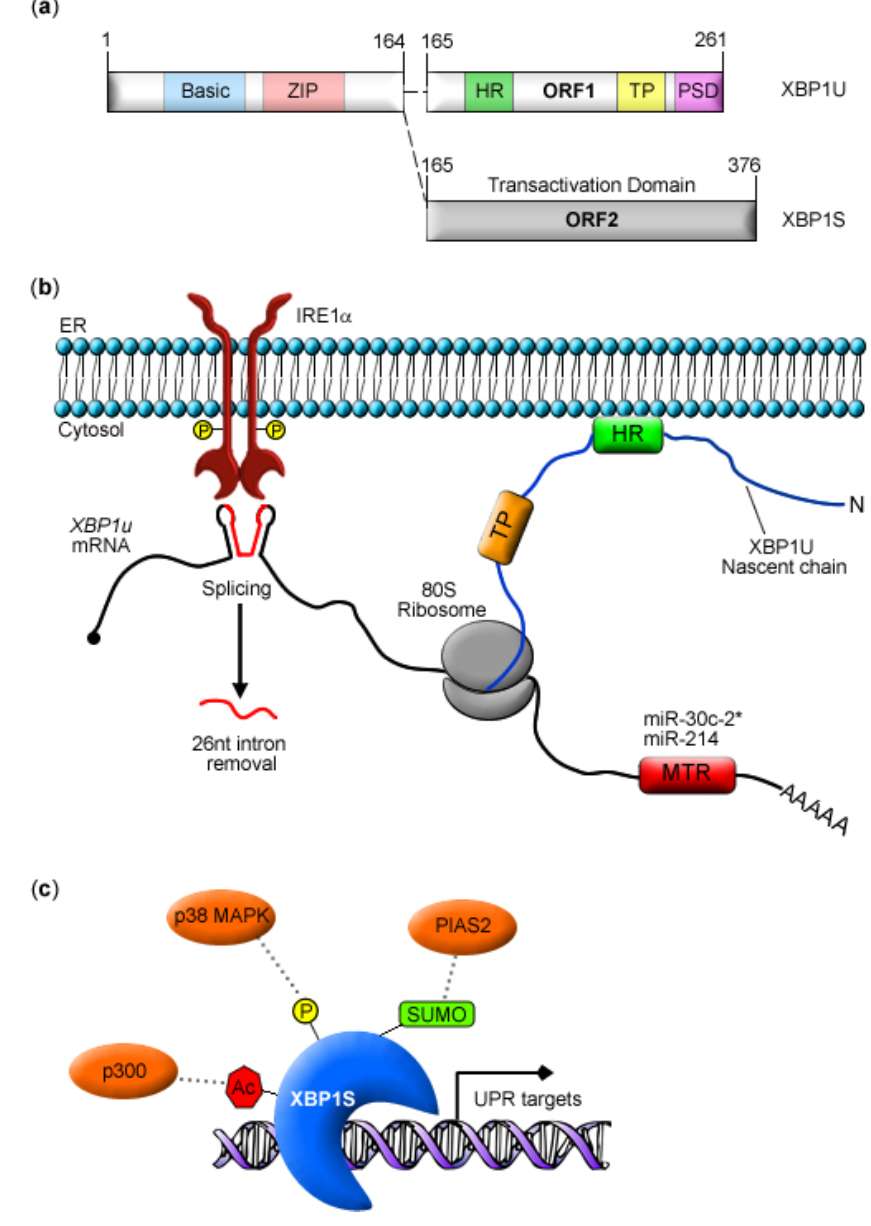
Figure 1. Regulatory elements of XBP1 expression and activity. (a) Figure of XBP1 protein variants (XBP1U and XBP1S). Numbers indicate amino acid positions. Basic and leucine zipper (ZIP) domains are indicated as well as ORF1 and ORF2 in the carboxyl-terminal domain of XBP1U and XBP1S, respectively. Hydrophobic region (HR), (cid:87)(cid:85)(cid:68)(cid:81)(cid:86)(cid:79)(cid:68)(cid:87)(cid:76)(cid:82)(cid:81)(cid:68)(cid:79)(cid:3) (cid:83)(cid:68)(cid:88)(cid:86)(cid:76)(cid:81)(cid:74)(cid:3) (cid:11)(cid:55)(cid:51)(cid:12)(cid:3) (cid:68)(cid:81)(cid:71)(cid:3) (cid:179)(cid:83)(cid:85)(cid:82)(cid:87)(cid:72)(cid:68)(cid:86)(cid:82)(cid:80)(cid:72) - (cid:86)(cid:88)(cid:86)(cid:70)(cid:72)(cid:83)(cid:87)(cid:76)(cid:69)(cid:79)(cid:72)(cid:180)(cid:3) (cid:71)(cid:72)(cid:74)(cid:85)(cid:68)(cid:71)(cid:68)(cid:87)(cid:76)(cid:82)(cid:81)(cid:3) (cid:11)(cid:51)(cid:54)(cid:39)(cid:12)(cid:3) (cid:71)(cid:82)(cid:80)(cid:68)(cid:76)(cid:81)(cid:86)(cid:3) (cid:82)(cid:73)(cid:3) XBP1U are also highlighted. (b) Model for XBP1 mRNA localization and processing at the ER membrane. The ER-localizing HR domain, TP domain, and microRNA targeting regions (MTR) are highlighted. The 26 nt intron spliced from XBP1u mRNA by IRE1 (cid:68) is depicted in red. (c) Post-translational modifications of XBP1S. Acetylation (Ac) by p300 increases stability and enhances transcriptional activity of XBP1S. SUMOylation (SUMO) by PIAS2 decreases activity of XBP1S. p38 MAPK-mediated phosphorylation (P) enhances XBP1S nuclear